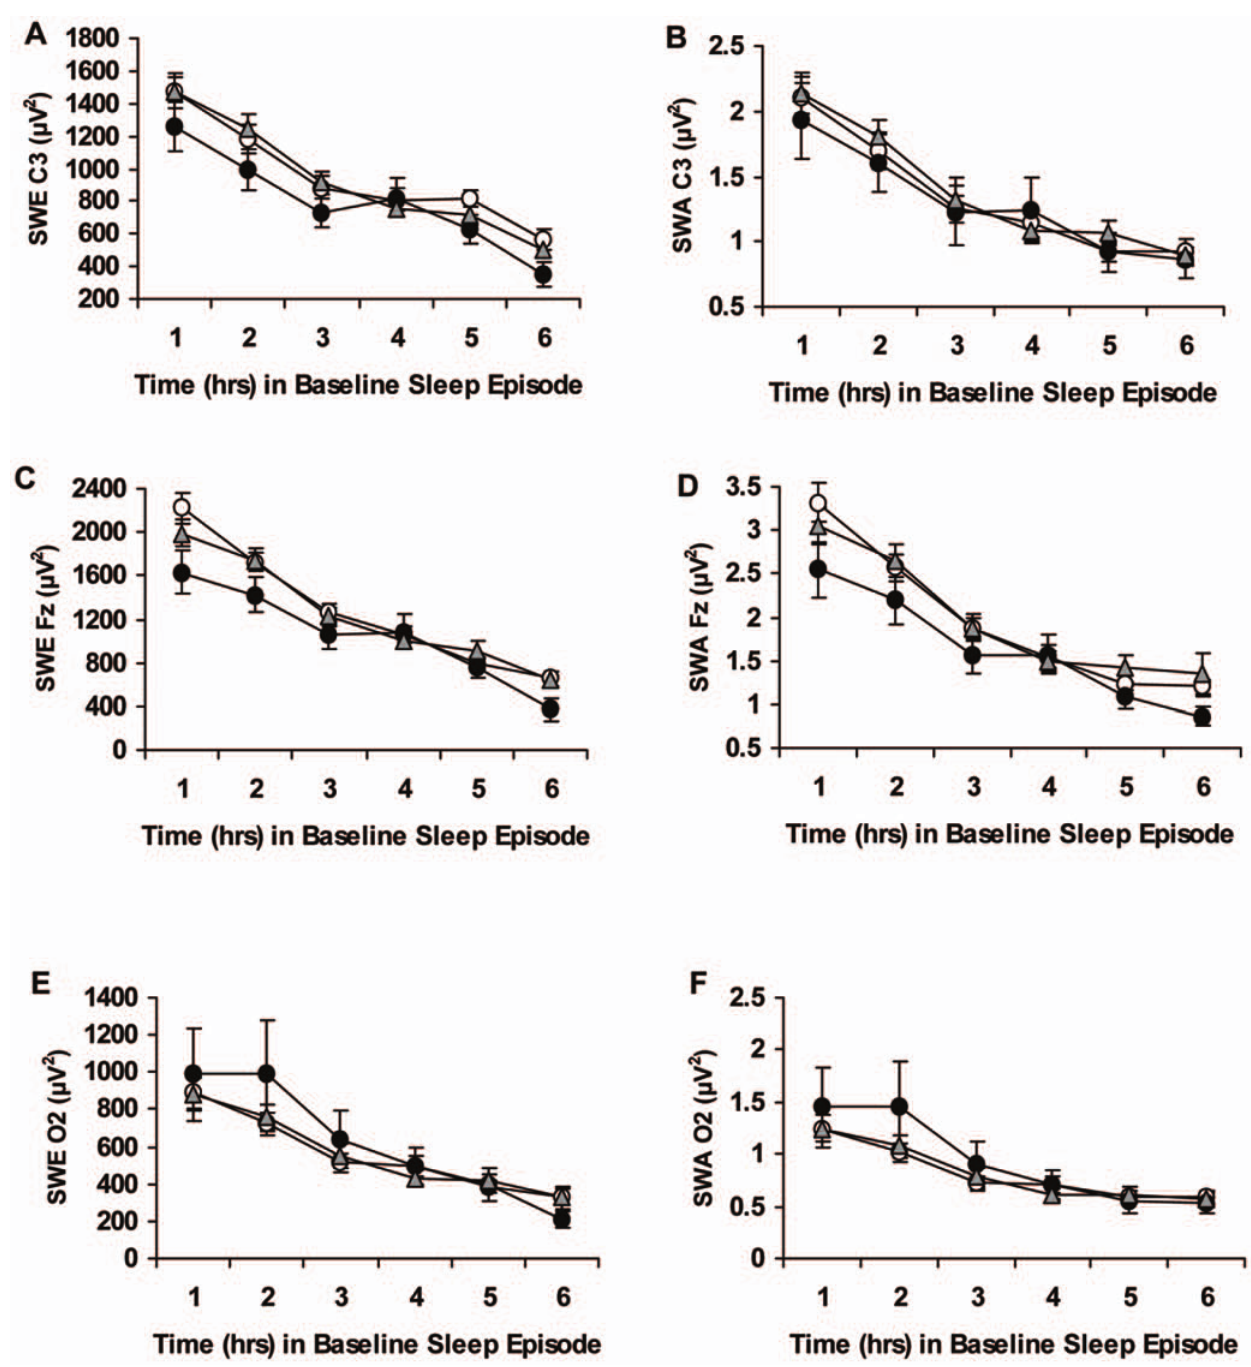
Figure 4. Hourly slow-wave energy and slow-wave activity during baseline for the PER3 genotypes. Mean ( 6 SEM) hourly slow-wave energy (SWE) and slow-wave activity (SWA) derived from the C3 (A, B), Fz (C, D) or O2 (E, F) channels at baseline for PER3 4/4 (open circles) , PER3 4/5 (gray triangles) and PER3 5/5 (closed circles) subjects. SWE and SWA significantly dissipated across the baseline night for all 3 channels, but not in a differential pattern across genotypes. In addition, the genotypes did not show significant differences in SWE or SWA derived from the C3, Fz or O2 channels.